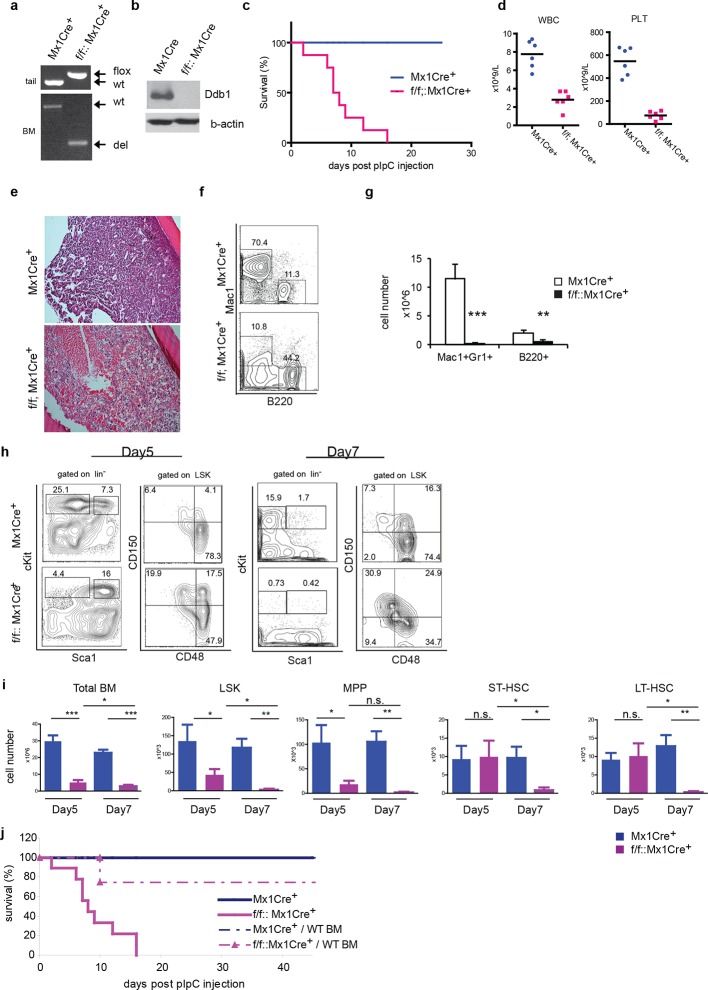
Deletion of Ddb1 in Ddb1f/f::Mx1Cre+ mice leads to bone marrow failure and acute lethality.(a) PCR on genomic DNA from tail or polyI:C injected bone marrow to detect wild type (wt), “floxed” (flox) and recombined (del) alleles of Ddb1 locus. (b) Western blot of bone marrow cells from polyI:C injected animals. (c) Survival curve of mice after polyI:C injection (n = 8 per group). (d) Peripheral blood counts 7 days after polyI:C injection (n = 6 per group). (WBC and PLT p=<0.0001). Black bar indicates average. (e) H&E staining of tibia sections 7 days after polyI:C injection. (f) Representative FACS plots of bone marrow cells. (g) Cellularity of bone marrow 7 days after poly:C injection. N=5 per group. (h) Representative FACS plots of bone marrow cells after polyI:C injection. (i) Cell numbers of total bone marrow and stem and progenitor cell populations in mice after polyI:C injection (n = 5 per group). *p<0.05. **p<0.01. ***p<0.001. (j) Non-polyI:C injected Ddb1f/f::Mx1Cre+ mice were lethally irradiated and transplanted with wild type bone marrows. Eight weeks after engraftment, DDB1 deletion was induced by polyI:C injection. Survival of these chimera mice (N= 4 per group) was followed and compared to polyI:C injected Ddb1f/f::Mx1Cre+ mice.